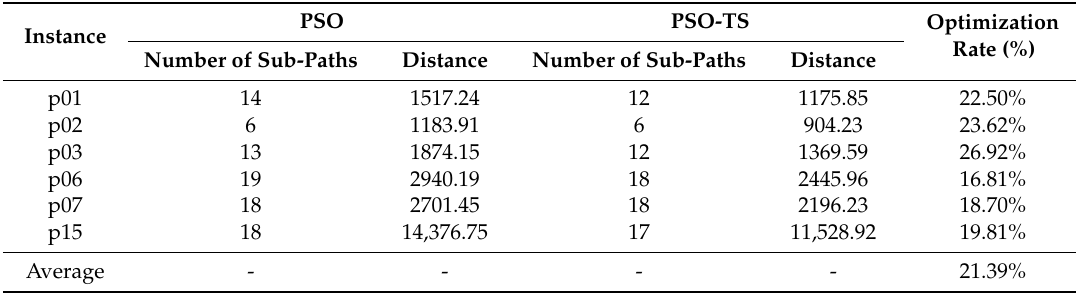
Table 6. Computational results of the PSO and